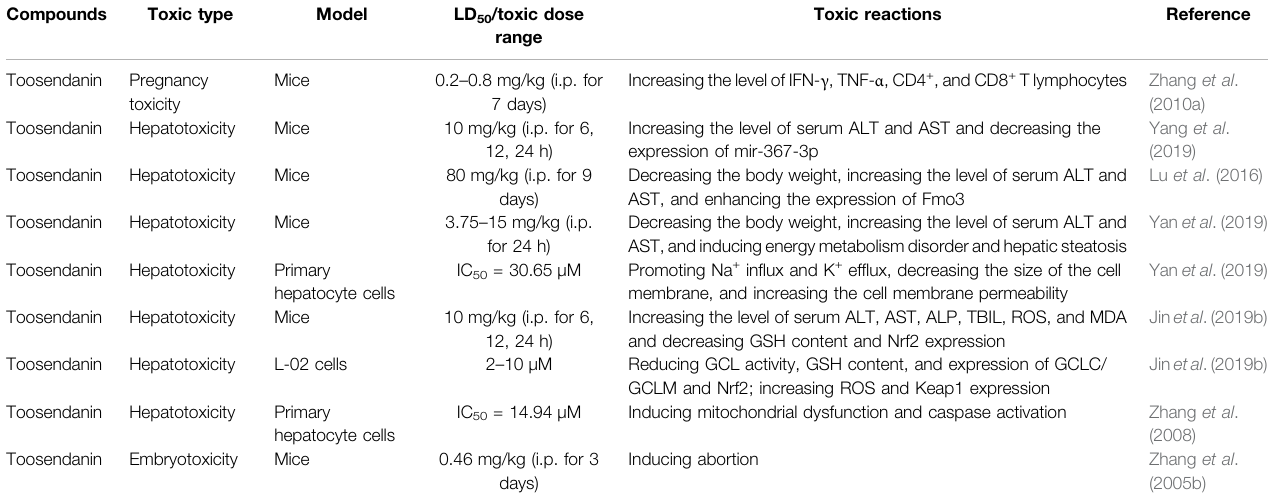
TABLE 3 | Toxicities and side effects of